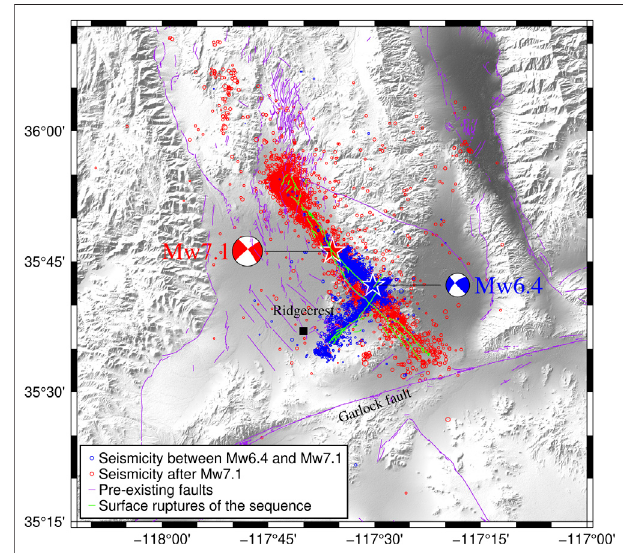
FIGURE 1 | Regional tectonic setting and aftershock distribution in the 2019 Ridgecrest earthquake sequence region. Blue and red beach balls represent the moment tensors ofthe Mw 6.4 and Mw 7.1 events, respectively (UnitedStatesGeologicalSurvey,USGS).Bluedotsindicateaftershocks that occurred between the Mw 6.4 and Mw 7.1 events, and red dots indicate aftershocks following the Mw 7.1 event. Purple lines show the previously mapped faults, while green lines represent the surface ruptures of the 2019 Ridgecrest sequence based on fi eld survey and optical remote-sensing images (Brandenberg et al.,